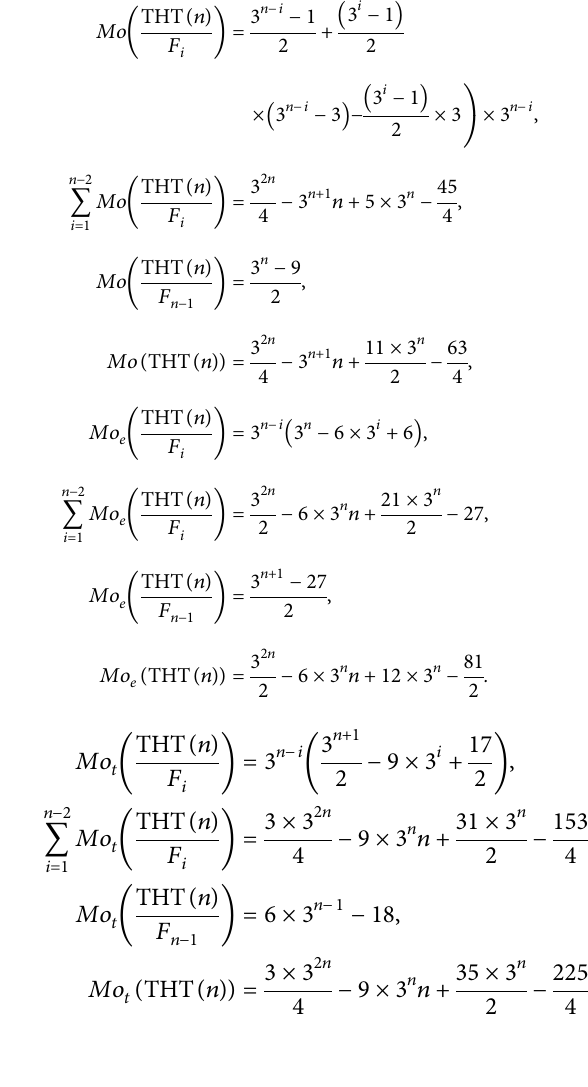
Figure 6: Graphical comparison of numerical values of distance- based indices of THT ( n ) .